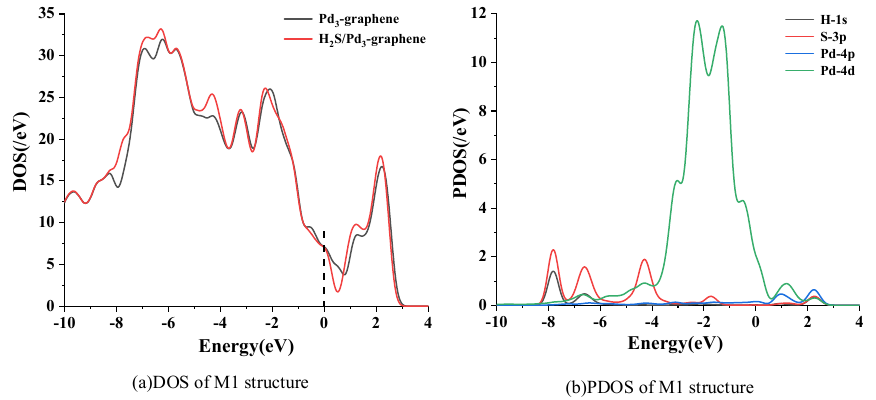
Figure 3. Density of states (DOS) and partial density of states (PDOS) of system M1. Dashed line represents the Fermi level.